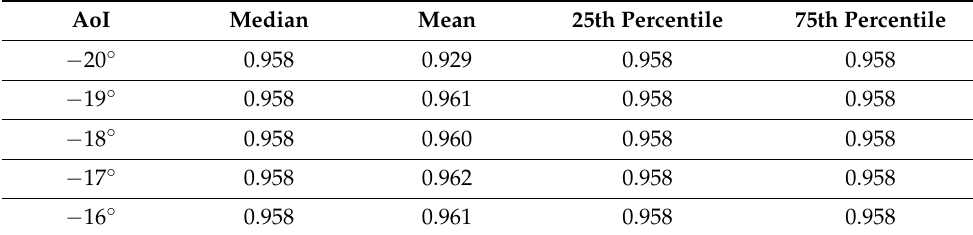
Table 6. Processed intensity data for pure transparent plastic.